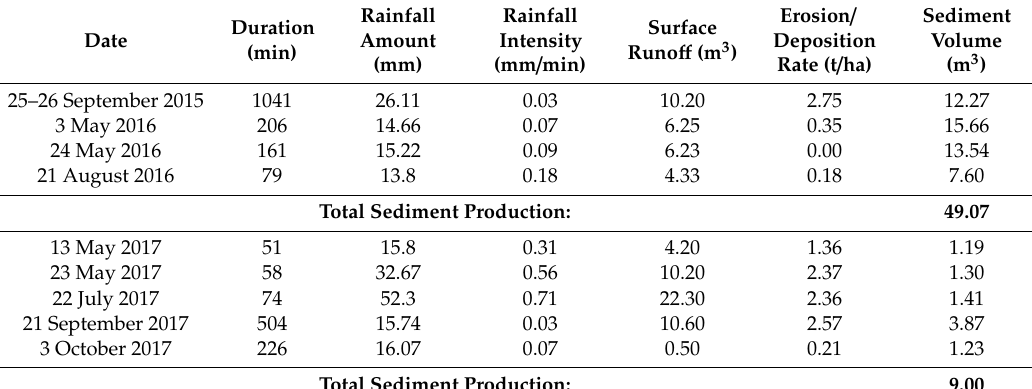
Table 5. Results from the EROSION-3D model calculated for the erosion-rainfall events (total rainfall amount >12.5 mm; [35–37] and function A.